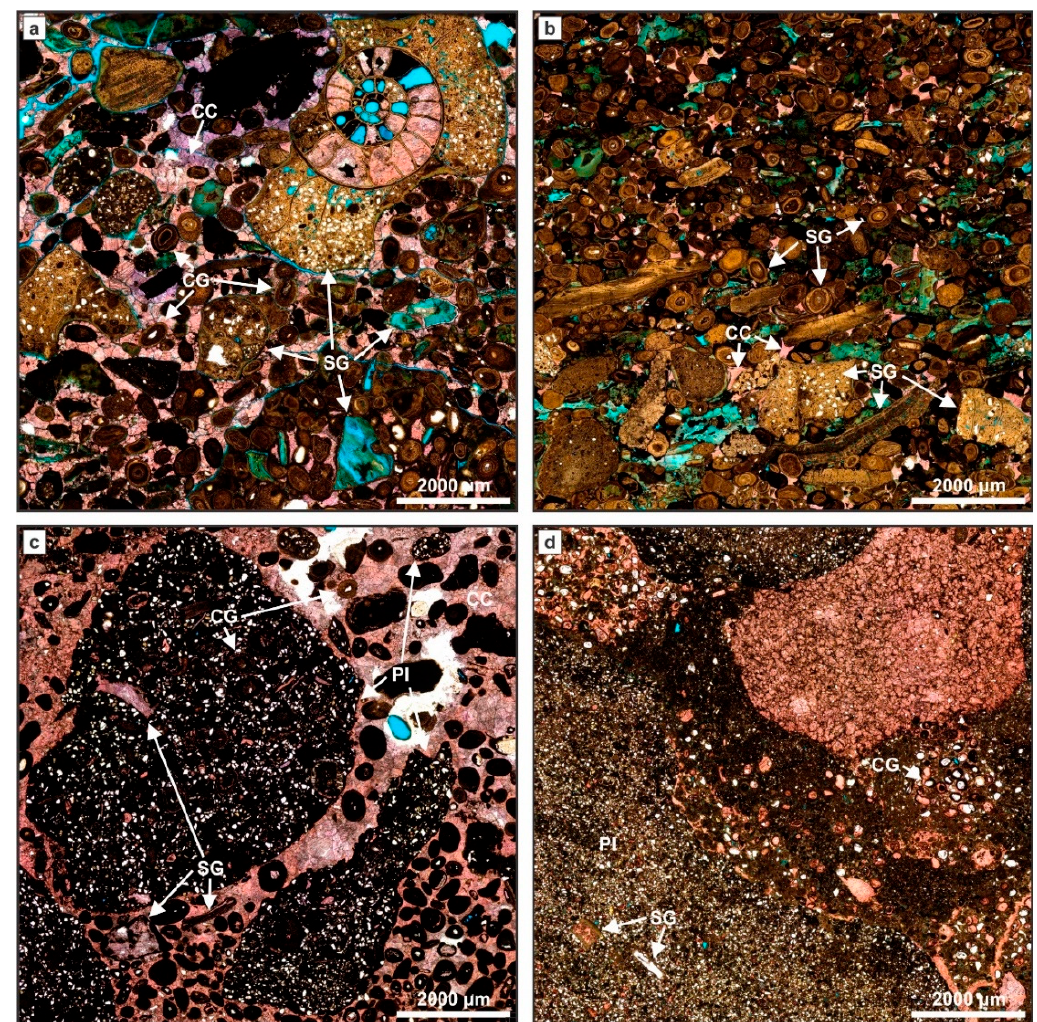
Figure 6. Photomicrographs of the phosphate-rich facies of the DPZ in plane-polarized light. ( a ) Sample CD13: phosphatized skeletal grains (SG), including ammonite in the upper-right corner, and coated grains (CG) cemented by red-stained calcite and purple-stained dolomite or ferroan calcite (CC), and predominantly intragranular or moldic porosity. ( b ) Sample CD15: Framework composed mostly of skeletal grains at the base of the photomicrograph, grading to predominantly coated grains at the top, with sparse calcite cementation and abundant intergranular, with subordinate intragranular and moldic porosity. ( c ) Sample MH6: two phosphate intraclasts (PI) and the edge of another one in the lower-left corner, containing silt-sized quartz and feldspar grains, partially phosphatized skeletal grains, and phosphate coated grains, with smaller intraclasts, skeletal and coated grains cemented by calcite ( d ) Sample MH7: the edge of a large phosphatic intraclast on the lower-left corner, containing abundant silt-sized quartz and feldspar grains, and rare partially phosphatized skeletal grains; in the upper-left corner and the right-hand side are two other intraclasts containing coarser detrital and coated grains, extensively cemented and replaced by calcite.